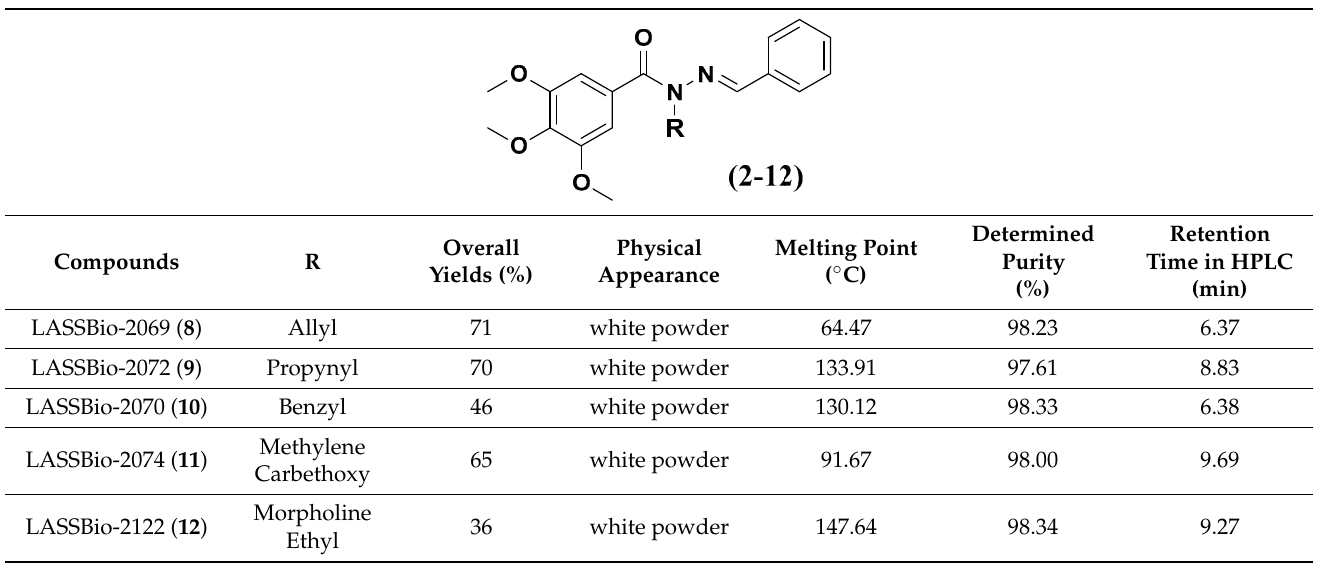
Figure 2. Synthetic methodology to obtain LASSBio ‐ 1586 ( 2 ) homologs and analogues from the starting material 13 . Table 1. Overall yields, physical aspect, melting point, purity by HPLC and retention time of Table 1. Cont. compounds 2 – 12